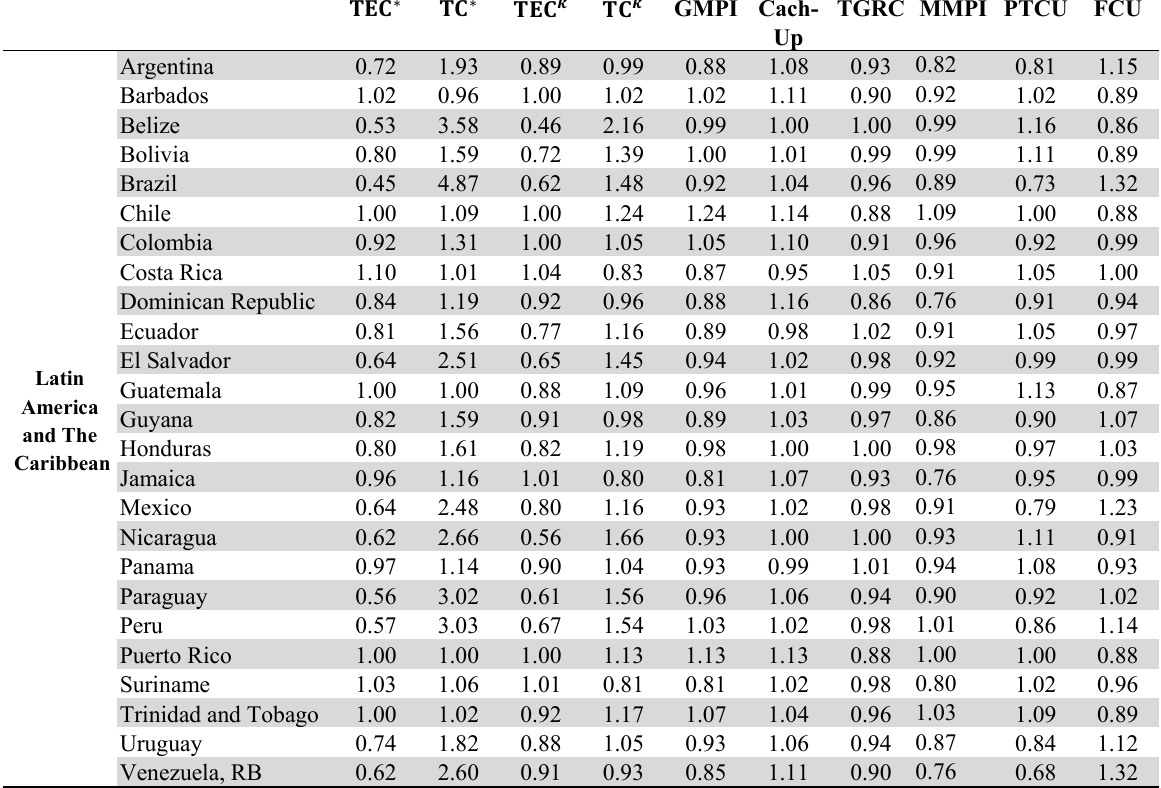
Calculations of Productivity Changes using the metafrontier Malmquist Method for Latin America and The Caribbean